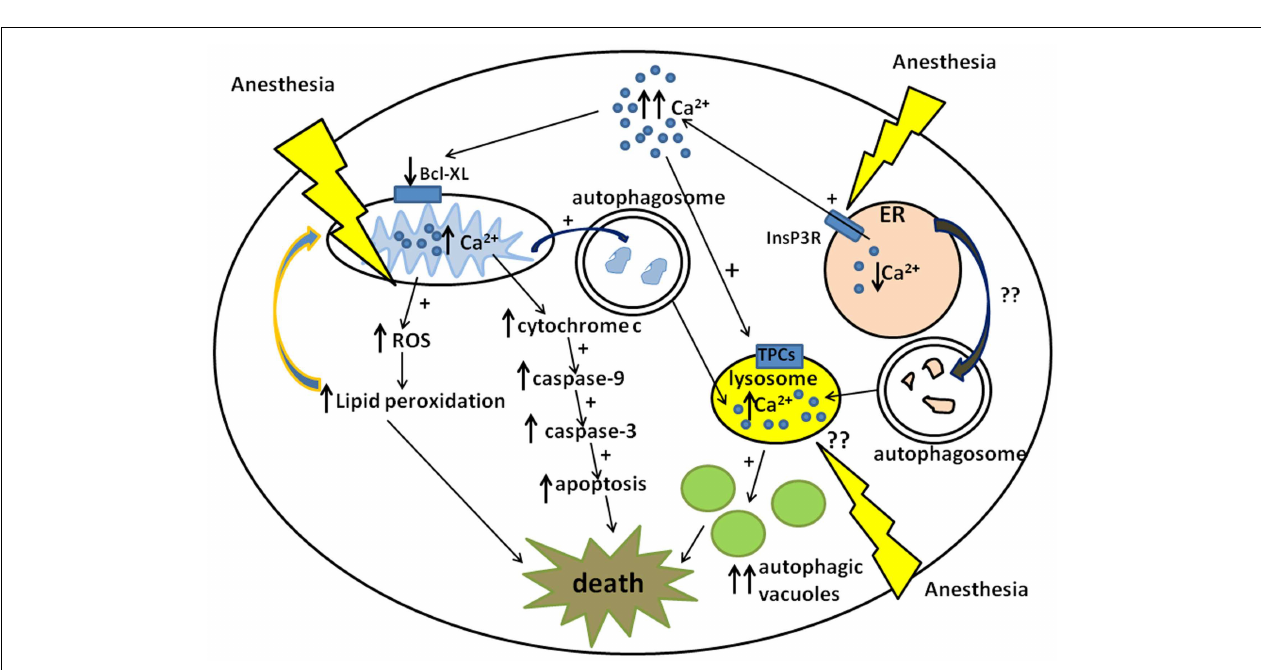
an uncontrollable source of ROS and cytochrome c whereas damaged ER can become an uncontrollable source of cytosolic Ca 2 + they have to be removed by autophagy leading to the excessive formation of autophagosomes and increase in autophagic load. (3) Lysosome-dependent pathway involves lysosome activation via nicotinic acid adenine dinucleotide phosphate (NAADP) gated two-pore channels (TPCs) which control Ca 2 + uptake into the lysosomes. An increase in intralysosomal level of Ca 2 + activates lysosomal activity which in turn promotes lysosomal and autophagosomal fusion, the formation of autophagic vacuoles and neuronal “self-eating.” Although it is proposed that anesthesia causes lysosomal activation indirectly via an increase in cytosolic Ca 2 + from the ER, it remains unclear whether anesthesia has a direct effect on lysosomal activation (via NAADP-gatedTPCs in